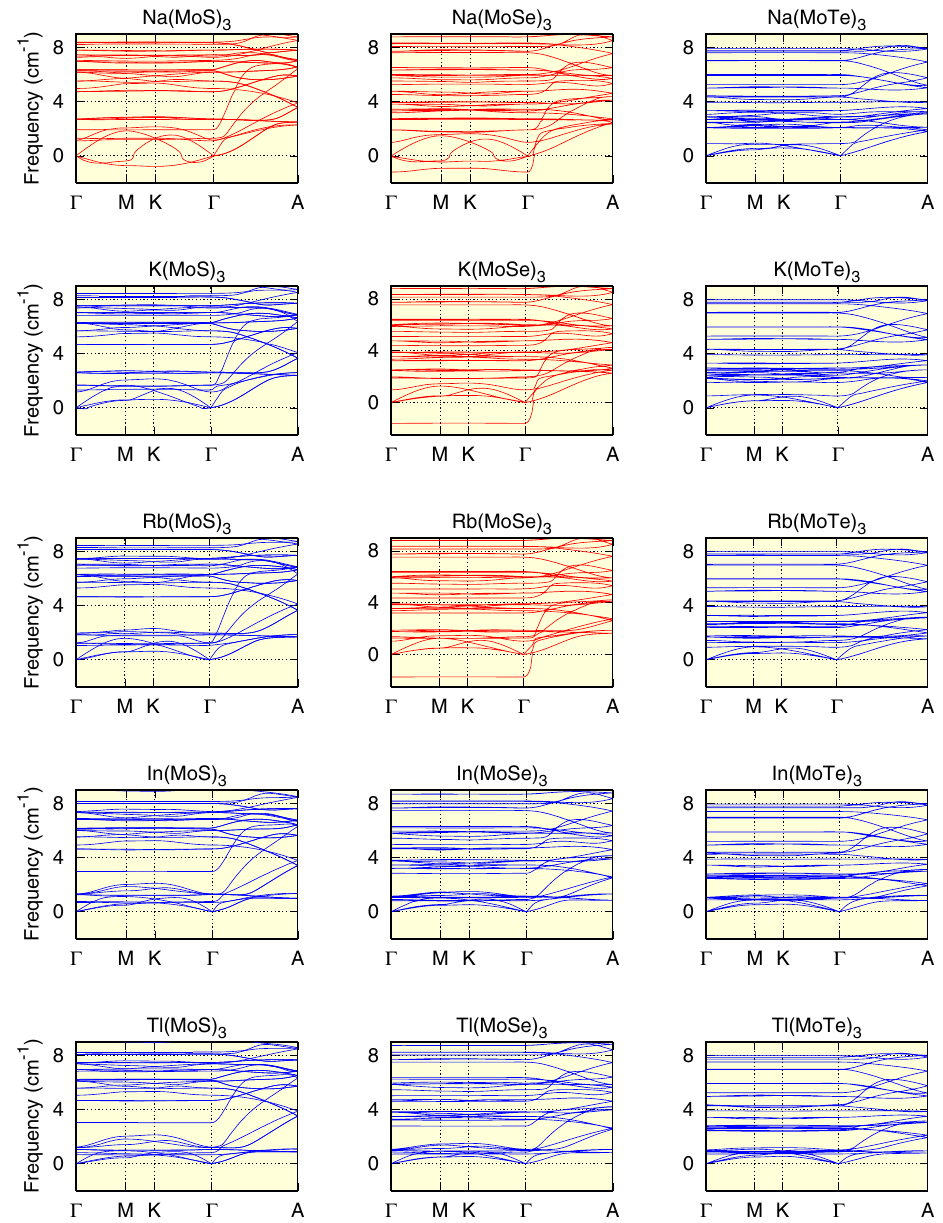
FIG. 6. Phonon spectra of 15 A ð MoX Þ 3 compounds with undistorted P 6 3 = m structure. The red and blue dispersions indicate spectra with soft phonons and without soft phonons,